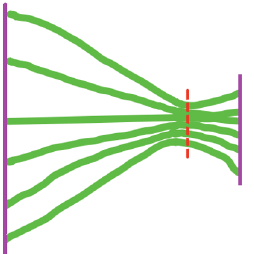
Figure 5 . The Ryu-Takayanagi minimal area surface defines a bottleneck for